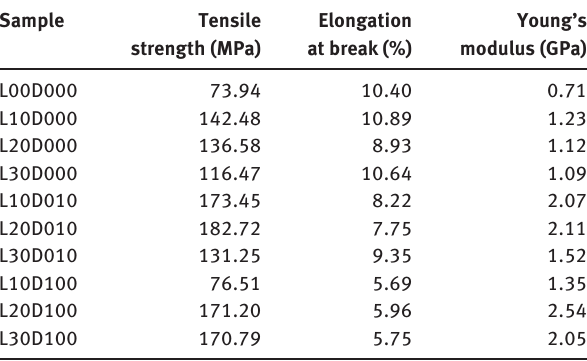
Table 2 Mechanical properties of photopolymer/clay nanocomposite.